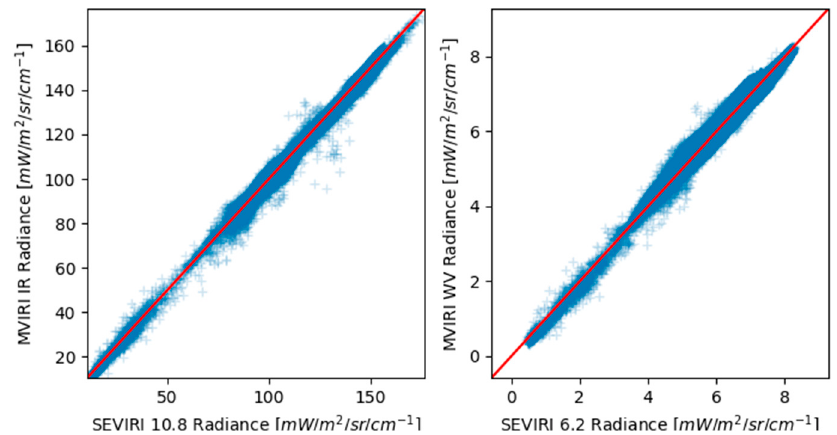
Figure 11. Results of the comparison between MVIRI and SEVIRI recalibrated measurements for